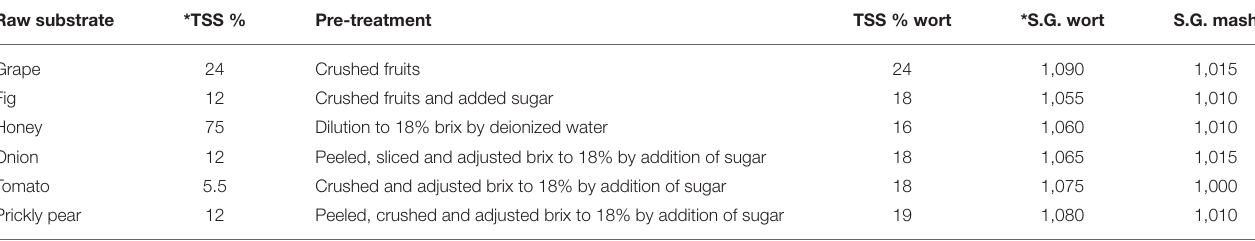
TABLE 3 | List of the raw substrates used in the primary alcoholic fermentation and pre-treatment; TSS % and S.G. readings of the wort and mash. Raw